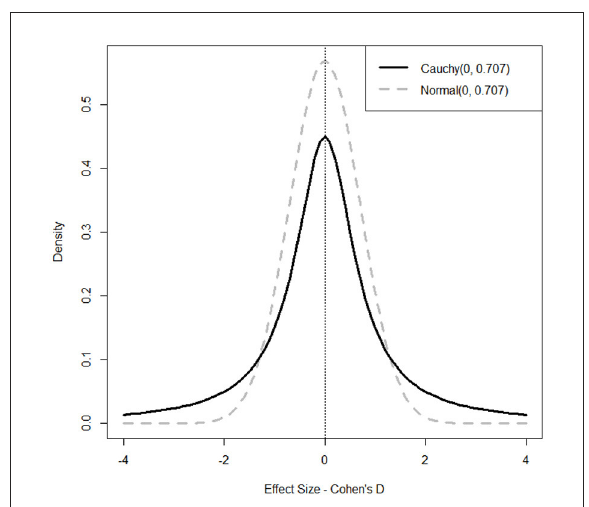
FIGURE3 Representation of Cauchy (0, 0.707) and Normal (0, 707)